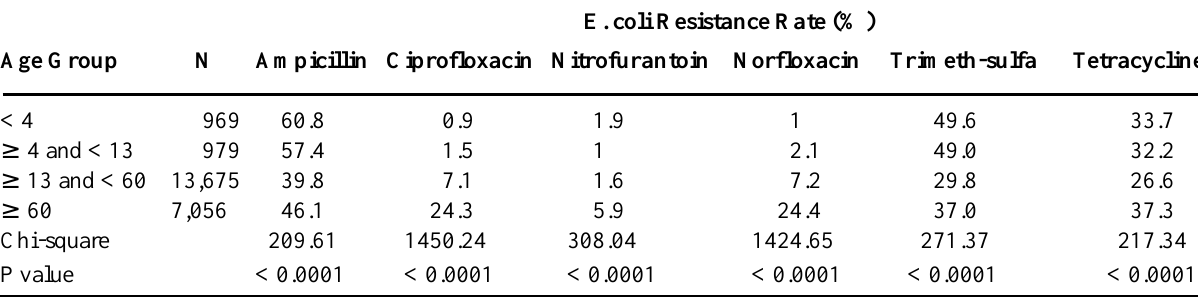
Table 3 – Chi-square test for comparisons of E. coli resistance rates (%) to various antimicrobials among age